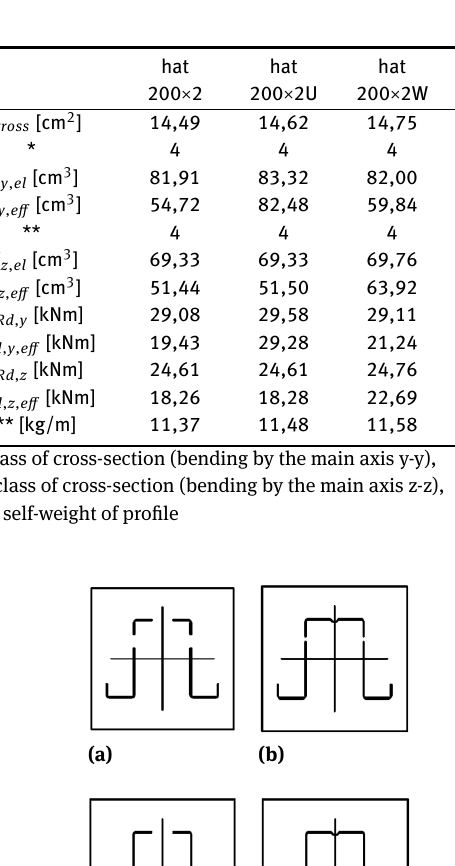
Table 3: Results of calculations, hat profiles with longitude stiffen- ers